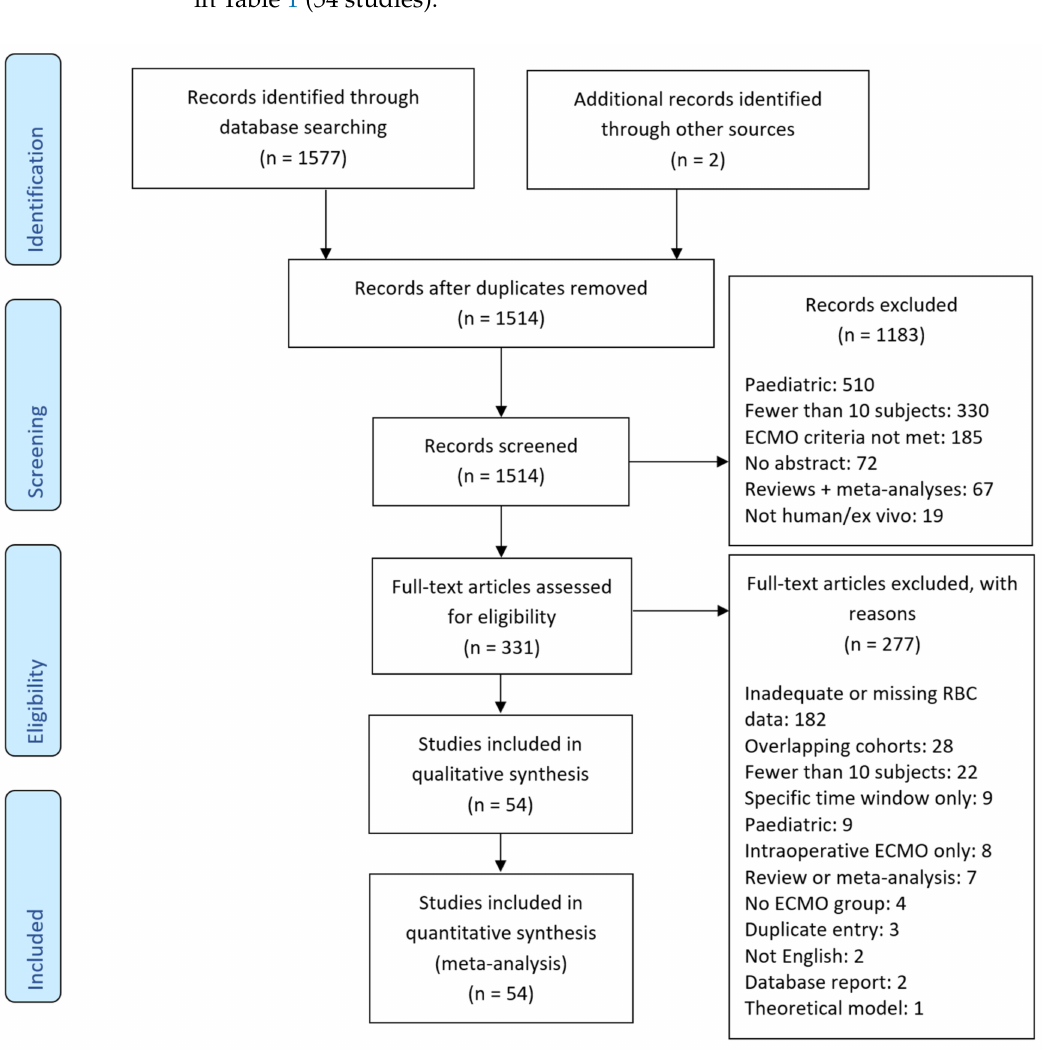
Figure 1. CONSORT